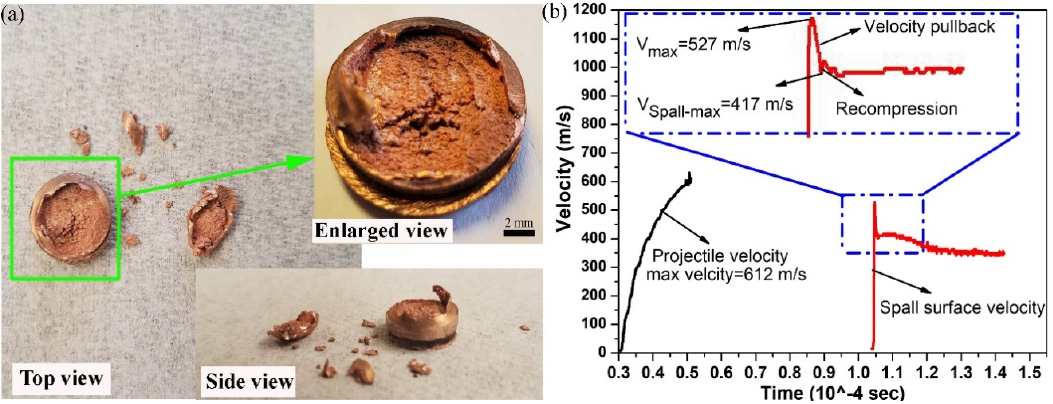
Figure 6. ( a ) Copper target showing large spalled top surface with one piece along with several smaller shards, and ( b ) velocity traces of composite projectile and copper free surface near shock wave breakout.